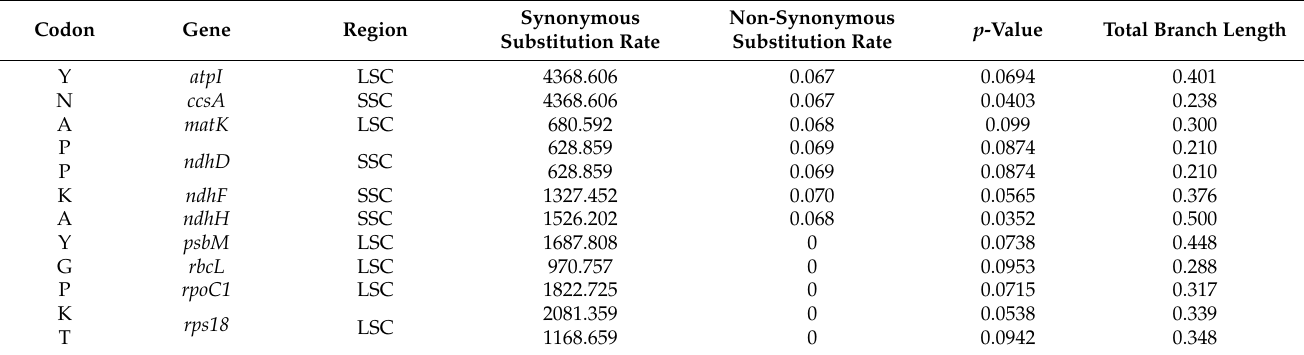
Table 4. The purifying selected sites detected in the 78 CDSs of six Pyracantha chloroplast genomes.